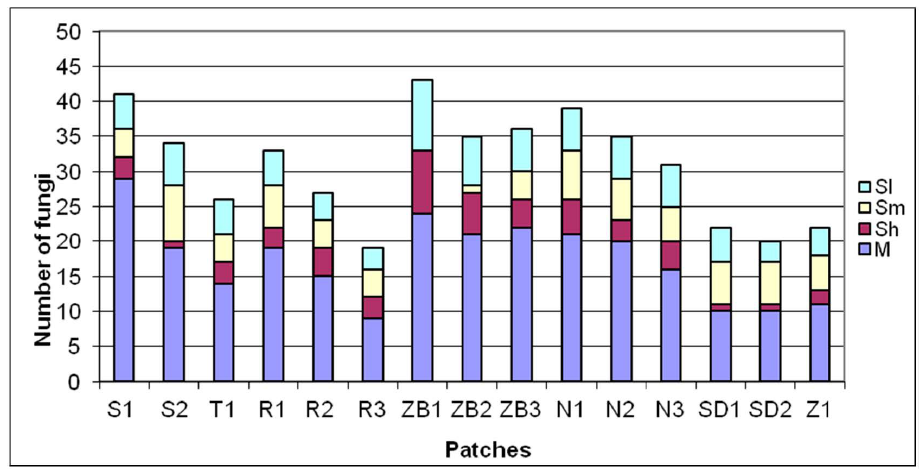
Figure 4. Contribution of bioecological groups of fungi in the patches. Abbreviations: M—